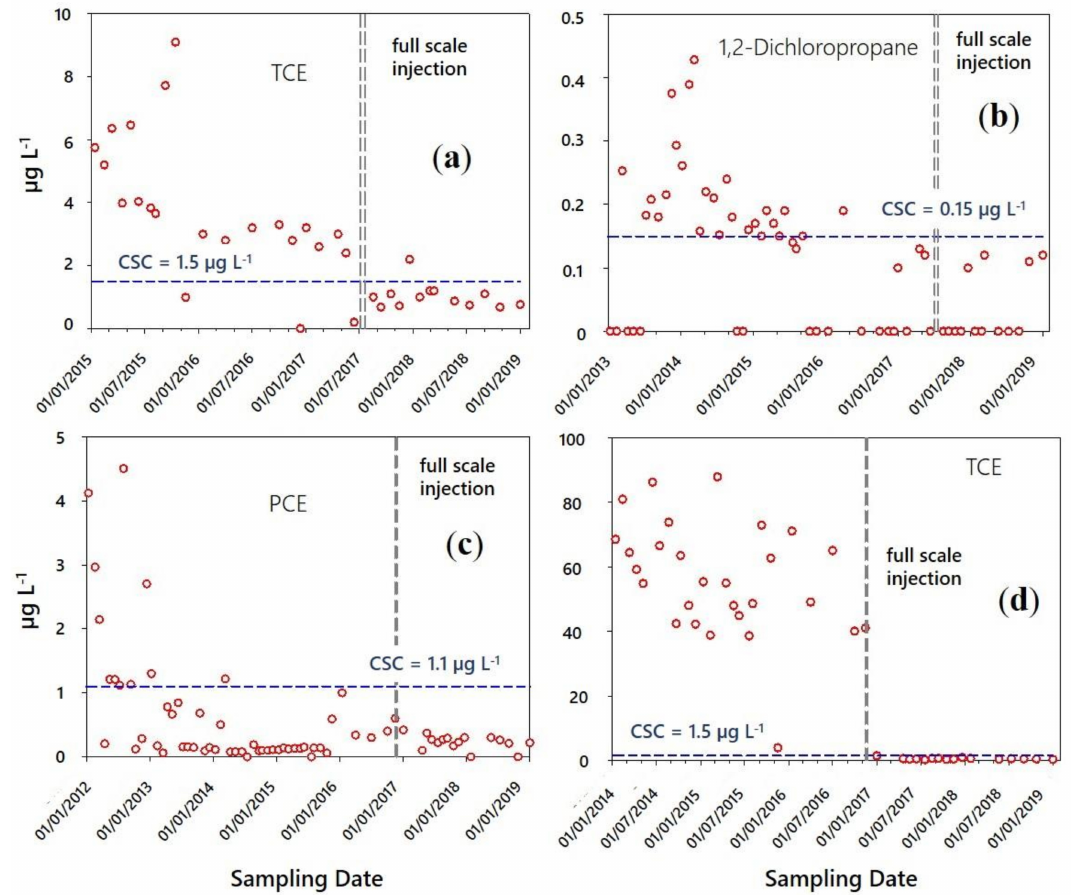
Figure 11. Concentration trend of chlorinated solvents measured in the intervention ( a , b ) area 2 and ( c , d ) area